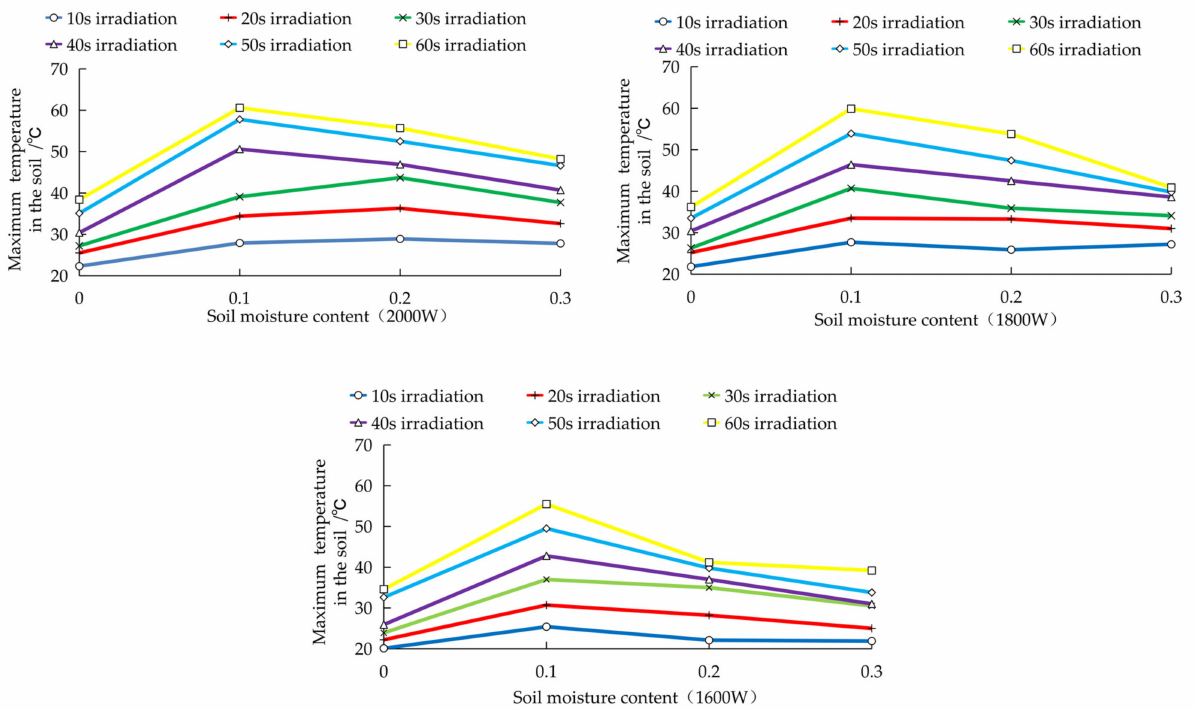
Figure 22. Change in the soil moisture content and the highest soil internal temperature. Table 6. Polynomial fitting results of the soil moisture content and soil internal temperature at microwave output power levels of 2, 1.8, and 1.6